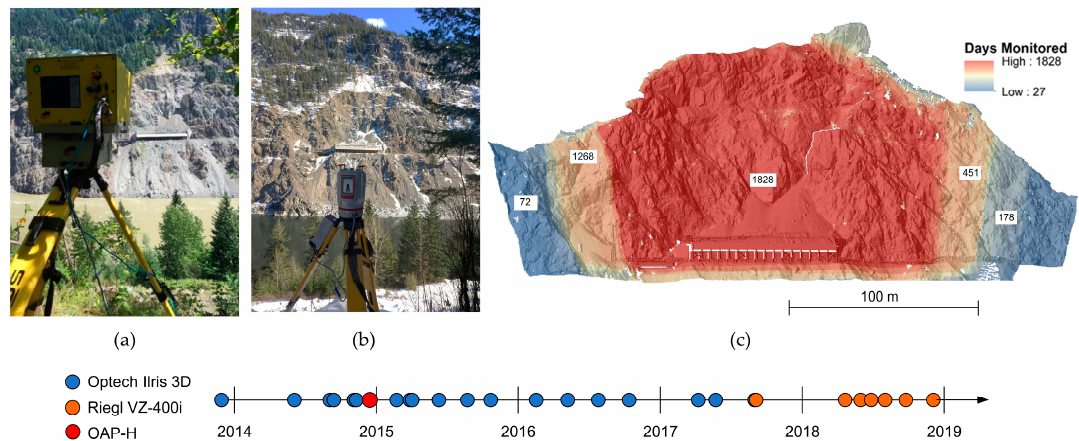
Figure 6. Data acquisition timeline. ( a ) The Optech ILRIS 3D-ER system; ( b ) The RIEGL VZ-400i system; ( c ) Hillshade site map colorized to show the monitoring duration with respect to slope extents. Warmer colors indicate areas that have been scanned more frequently and through longer time intervals.